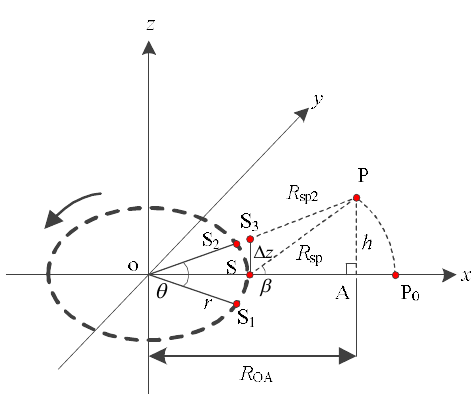
Figure 7. The model of interferometric ArcSAR.